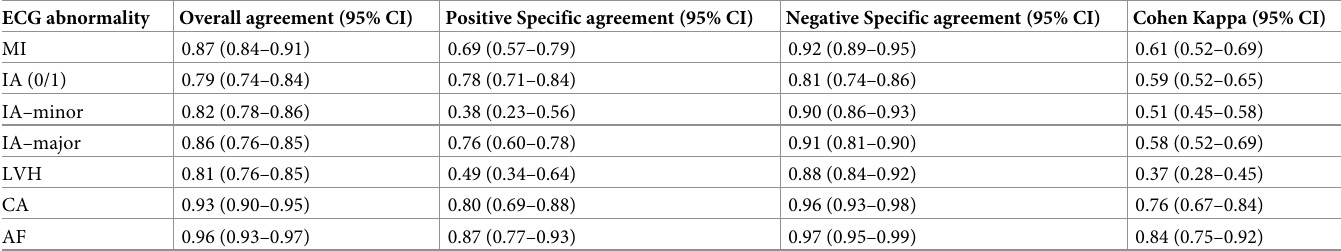
Table 3. The positive agreement and negative agreement scores, and Cohen Kappa’s for the four ECG abnormalities based on Minnesota